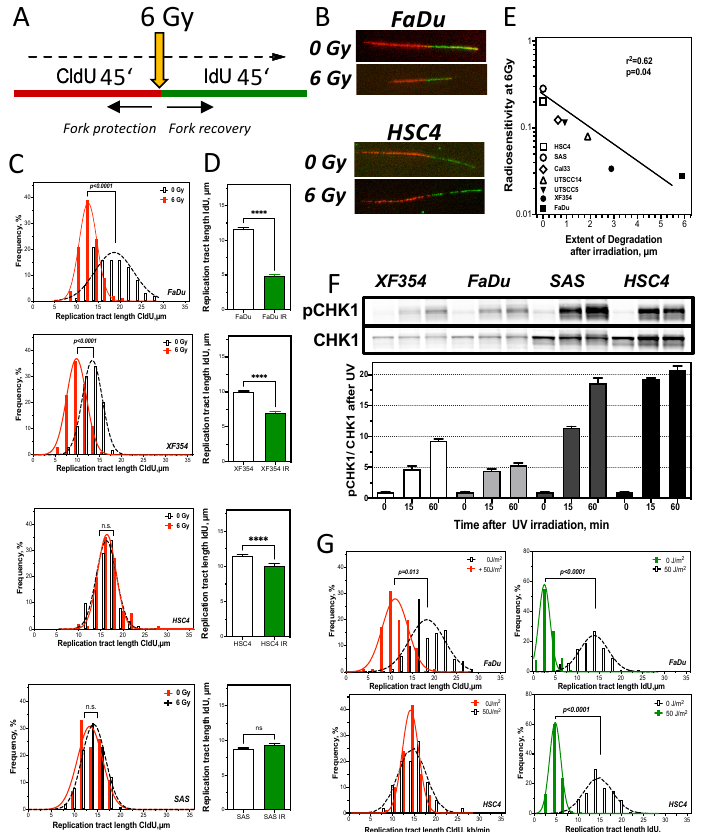
Figure 4. Resistance is mediated by DNA replication fork stability and active DNA damage response of S phase. ( A , B ) Treatment scheme and examples of replication tracts and replication tract lengths before (CldU) ( C ) and after (IdU) ( D ) irradiation. Correlation of replication tract length and cellular radiosensitivity ( E ). ( F ) Qualitative and quantitative activation of CHK1/pCHK1 after UV irradiation. Replication tract length before (left) and after UV irradiation (right) ( G ). p -values represent errors of the mean. Asterisks (*) represent significant differences (**** p < 0.0001; Student´s t